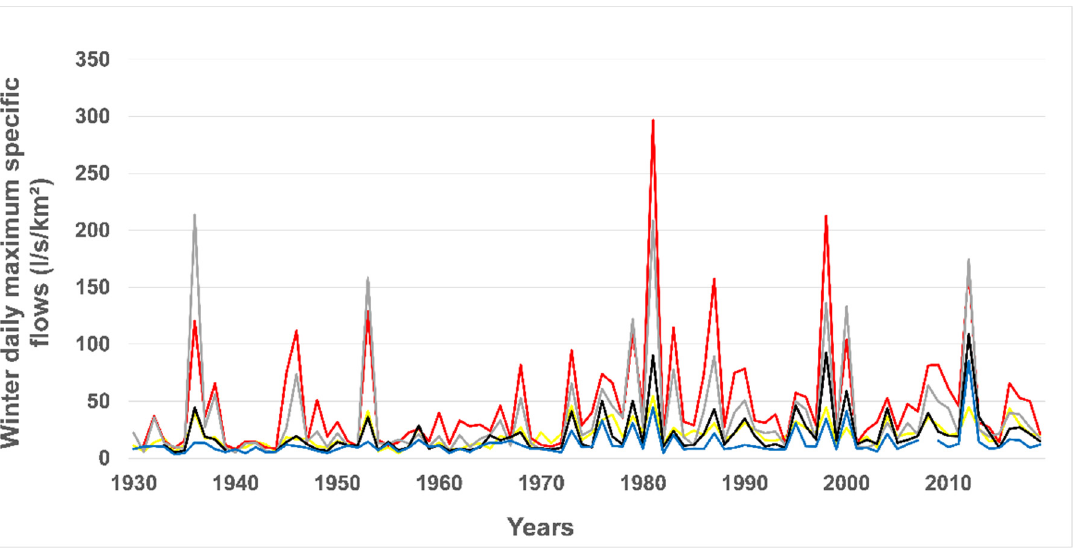
Figure 5. Interannual variability of winter daily maximum specific flows (l/s/km²) in the Southwest- ern hydroclimatic region from 1930 to 2019. Petite Nation River: yellow curve; Du Nord River: Red curve; L’Assomption River: grey curve; Matawin River: black curve; Vermillon River: blue curve.